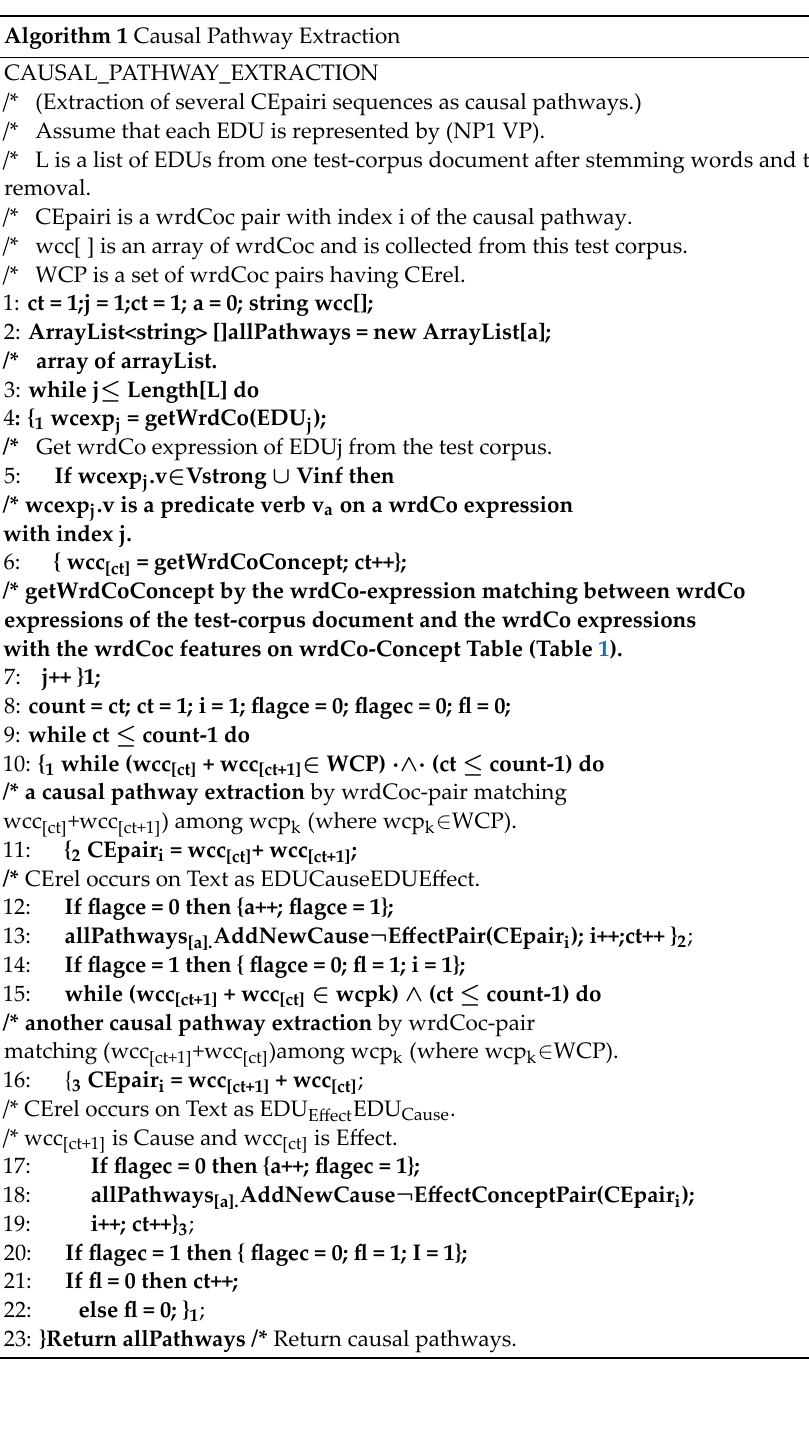
Algorithm 1 Causal Pathway